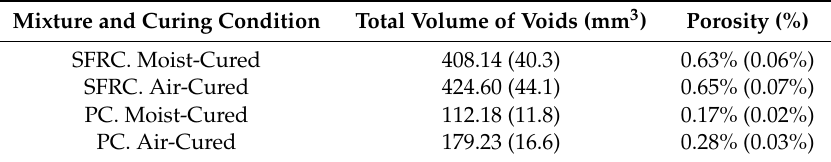
Table 2. Total volume of voids and